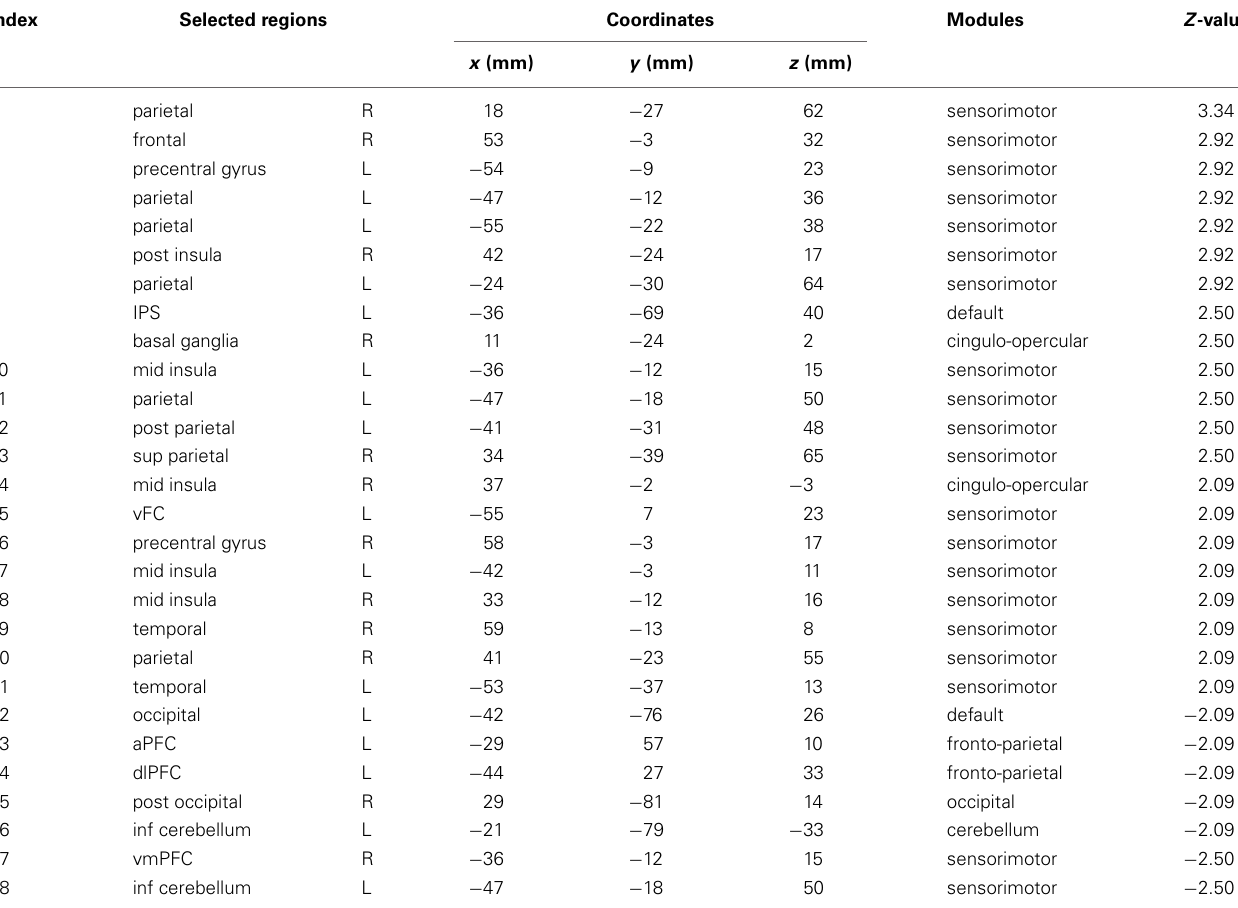
Table 1 | Brain regions involved in the discriminatory pattern with | Z | > 1 .